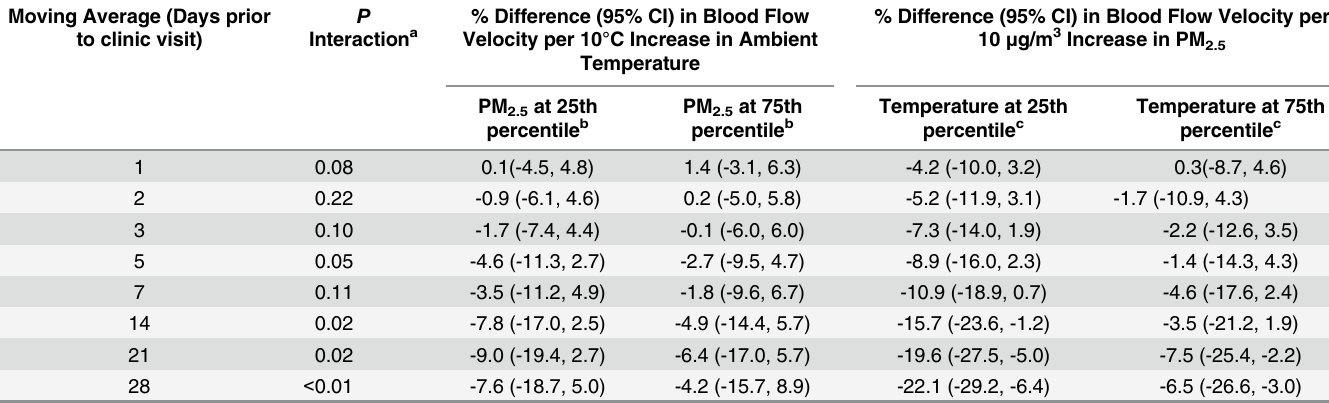
Abbreviations: PM 2.5 , fi ne particulate matter.